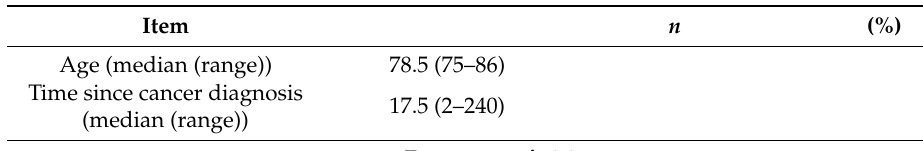
Table 2. Participants’ characteristics ( n = 50).